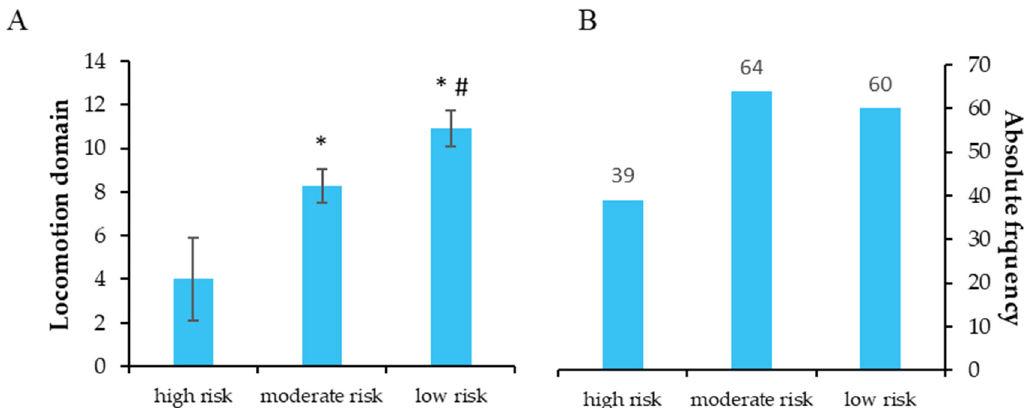
Figure 3. ( A ): Mean ± standard deviation for each risk group of the psychological domain. * p < 0.001 compared to high risk. ( B ): Absolute frequency of older adults in each risk group.